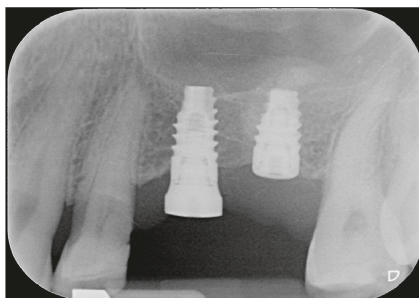
Figure 6: 4 years’ follow-up radiography. Sinus floor level is maintained on the top of both implants’ apex and appears well corticalized. Crestal bone remodelling occurred around implant #26, not exceeding the smooth